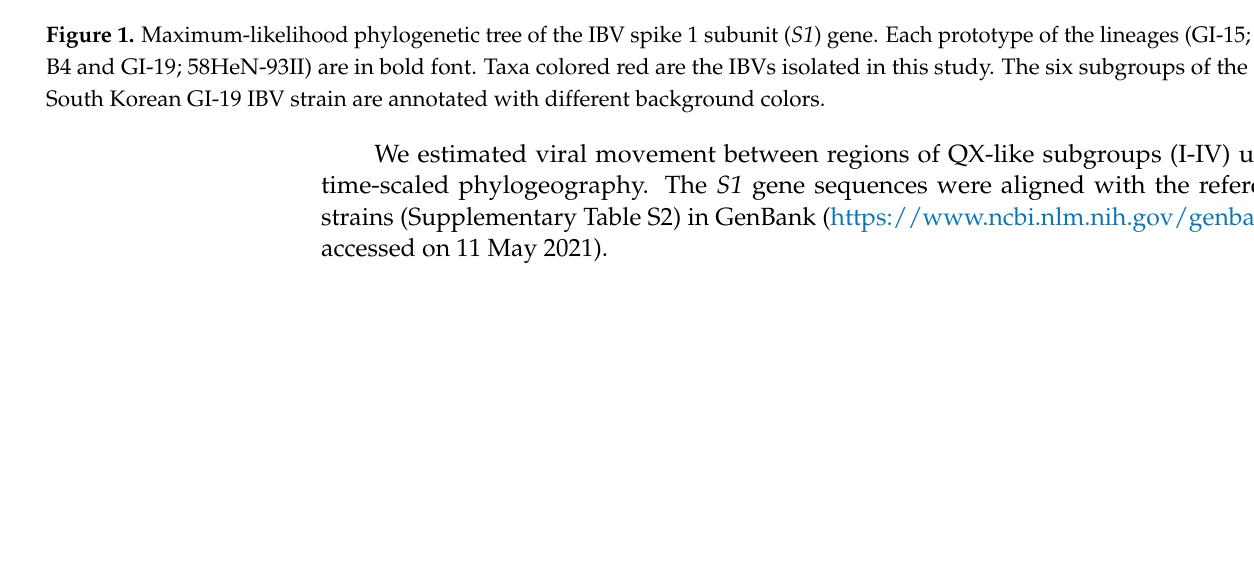
Table 1. Nucleotide 1 and amino acid identities of the S1 gene 1 between the South Korean GI-19 IBVs.